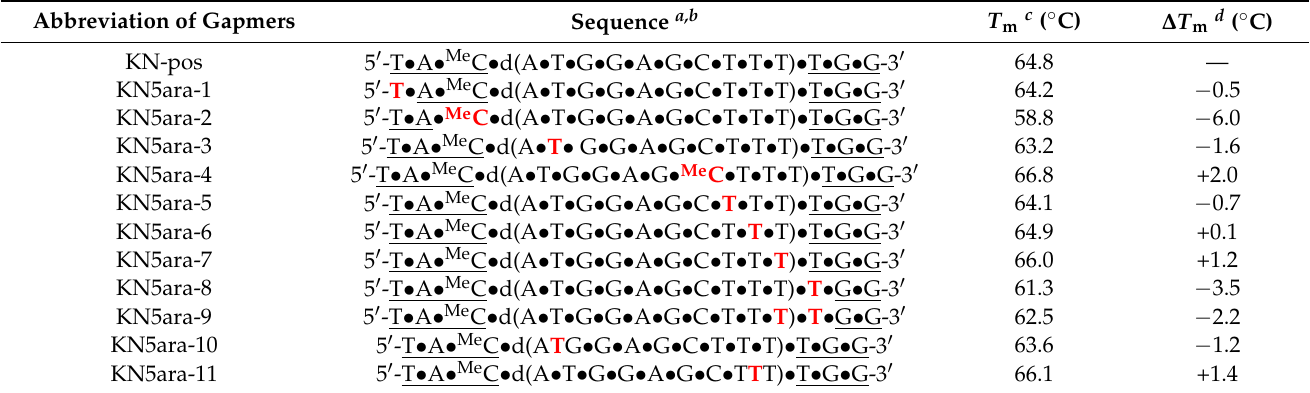
Table 1. Sequence of each gapmer and T m values of duplexes containing these